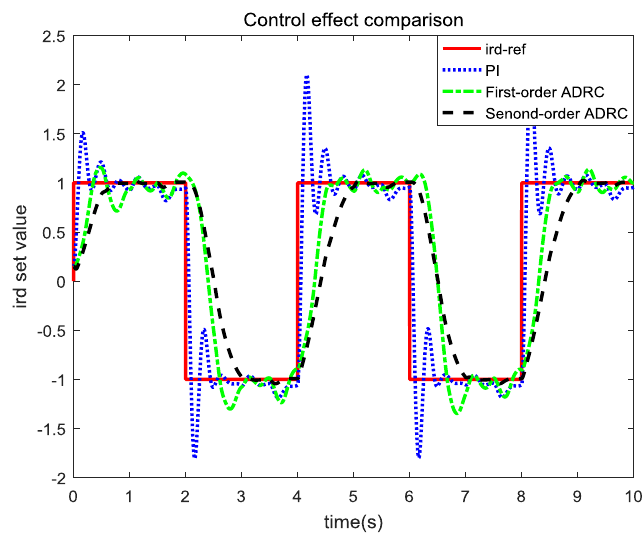
Figure 15. Comparison of control effects under the system model parameters change.